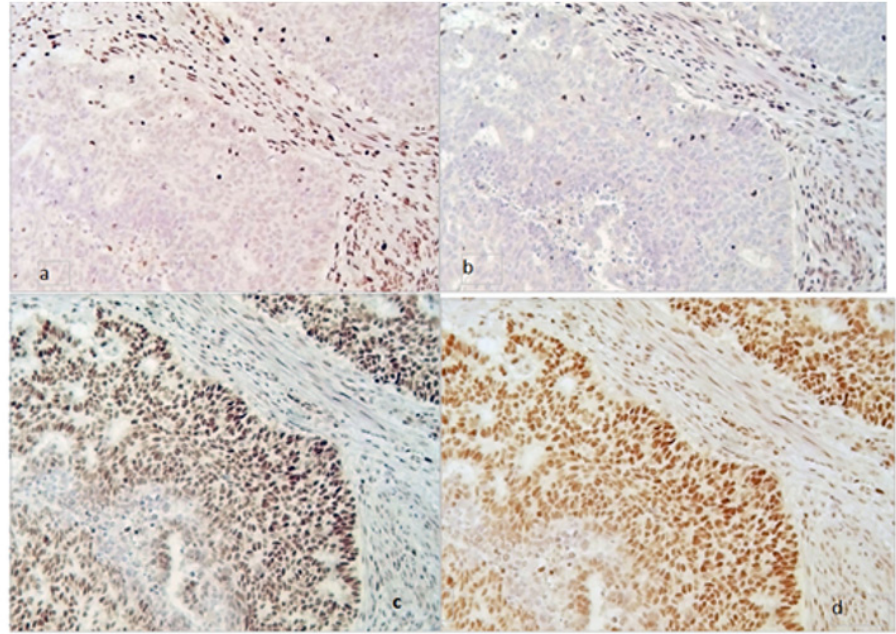
Figure 1. MMR deficiency tumor (magnification 200×). Loss of MSH2 ( a ) and MSH6 ( b ) expression in neoplastic cells with internal positive control of stromal cells (stained brown). Persistence of MLH1 ( c ) and PMS2 ( d ) both in the neoplastic and in the stromal cells (stained brown).